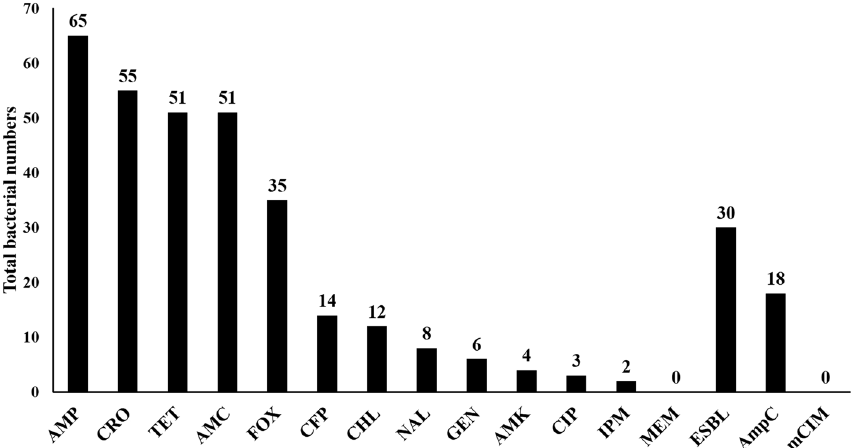
Figure 1. Level of antimicrobial resistance to different antibiotics and phenotypic characters of the isolates. The isolates showed high resistance rates to tetracycline and almost all tested β-lactam antibiotics, except carbapenems with low resistance rates to other tested antibiotics. Phenotypic ESBLs and AmpCs production were detected within 40.5% (95% CI 29.3–52.6%), and 24.3% (95% CI 15.1–25.7%) of the isolates, respectively. On the other hand, all the isolates were negative for phenotypic carbapenemases production according to modified carbapenem inactivation assay (mCIM). Antibiotics: Ampicillin (AMP), ceftriaxone (CRO), tetracycline (TET), amoxicillin–clavulanic acid (AMC), cefoxitin (FOX), cefoperazone (CFP), chloramphenicol (CHL), nalidixic acid (NAL), gentamicin (GEN), amikacin (AMK), ciprofloxacin (CIP), imipenem (IPM), and meropenem (MEM).